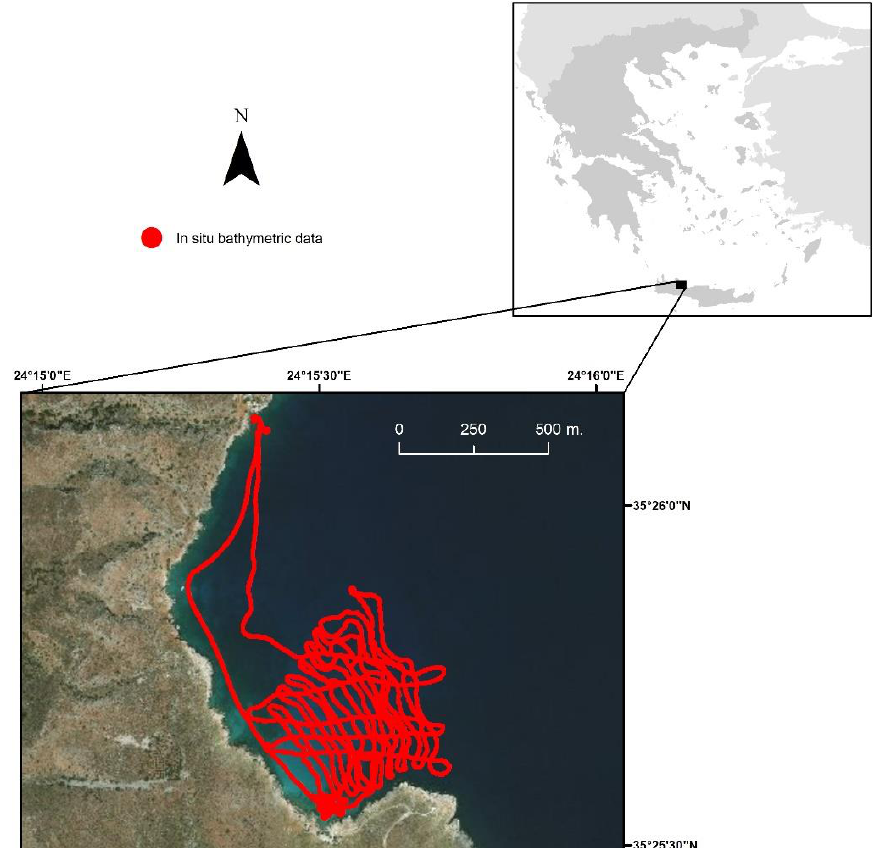
Figure 1. Obros Gyalos study site at Apokoronas area; with red dots the collected in-situ data using a single beam echosounder.